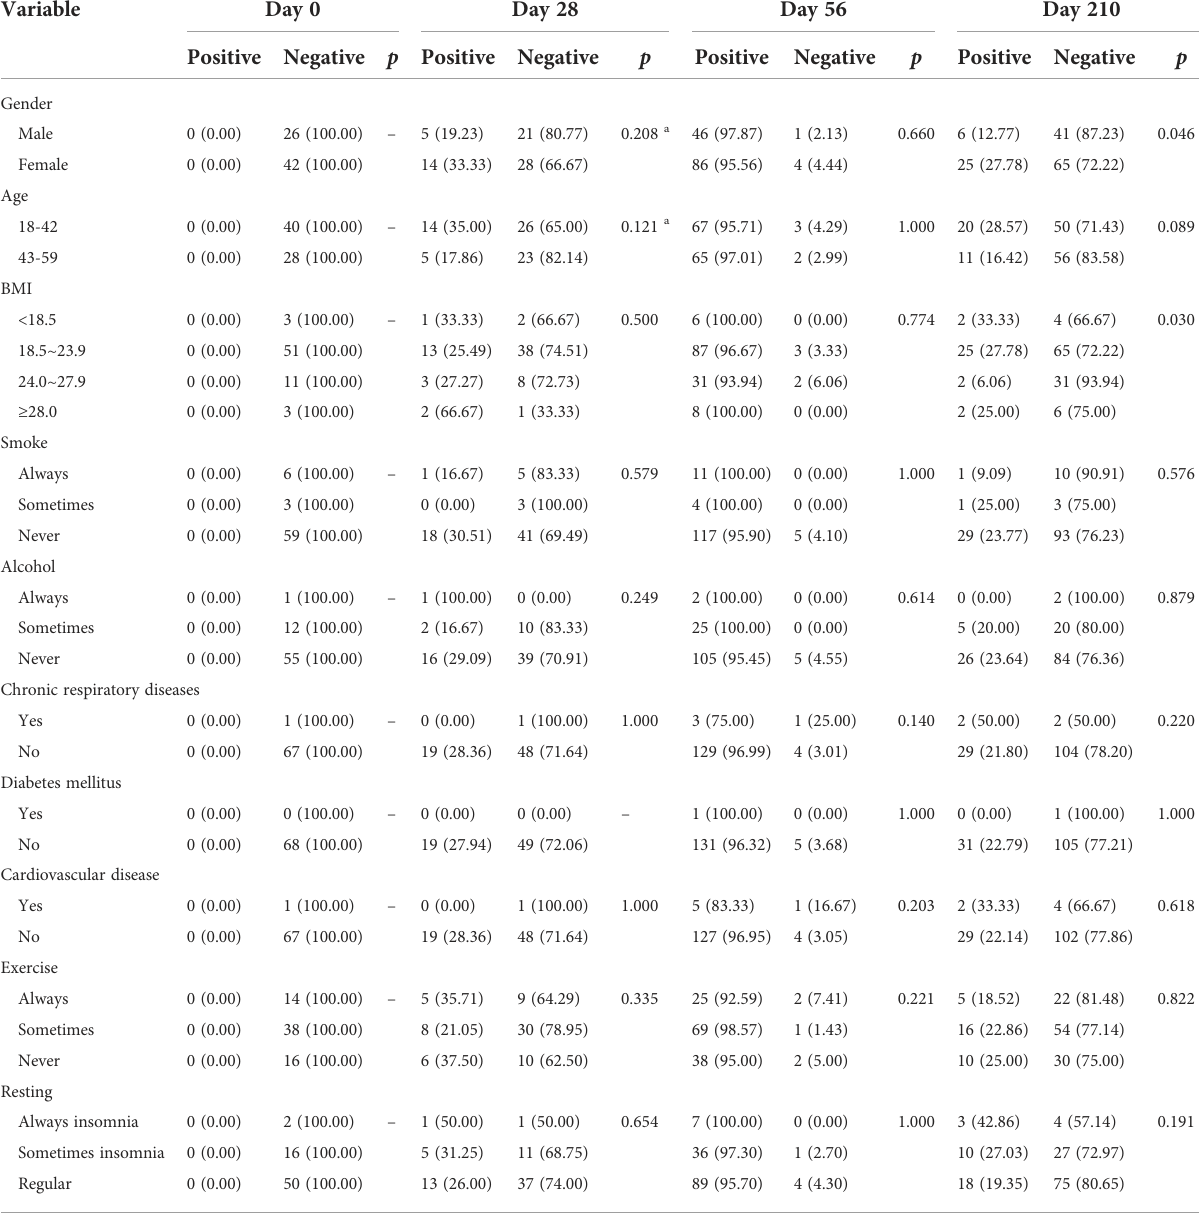
TABLE 4 Associations between participants ’ characteristics and antibodies to